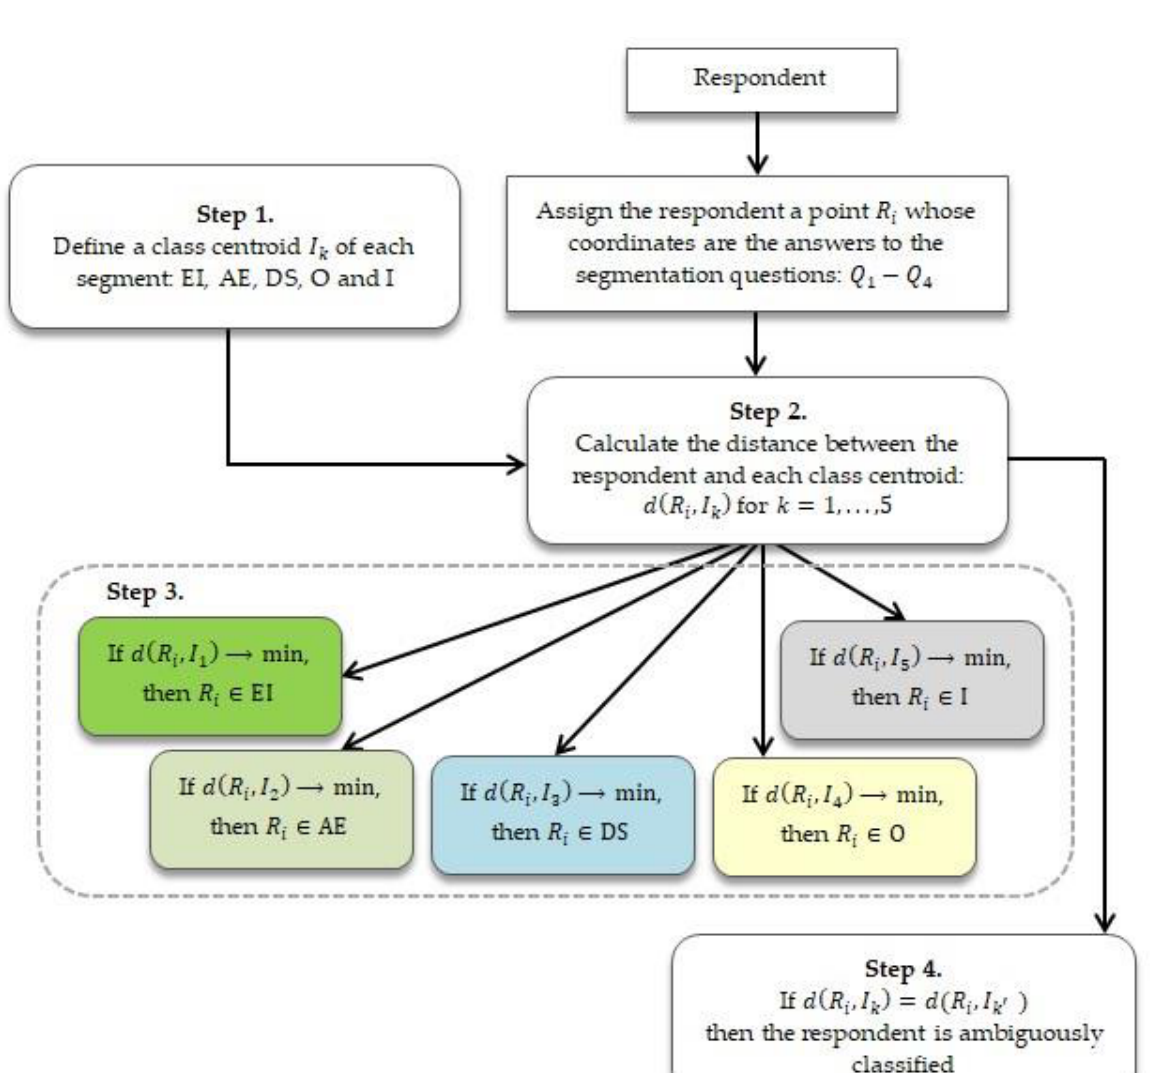
Figure 2. The diagram illustrating the segmentation procedure.